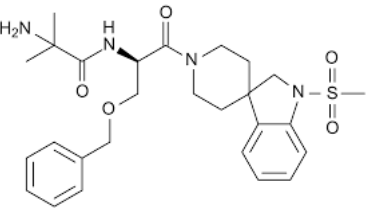
Figure 21. Chemical structure of ibutamoren. Formula: C 27 H 36 N 4 O 5 S.